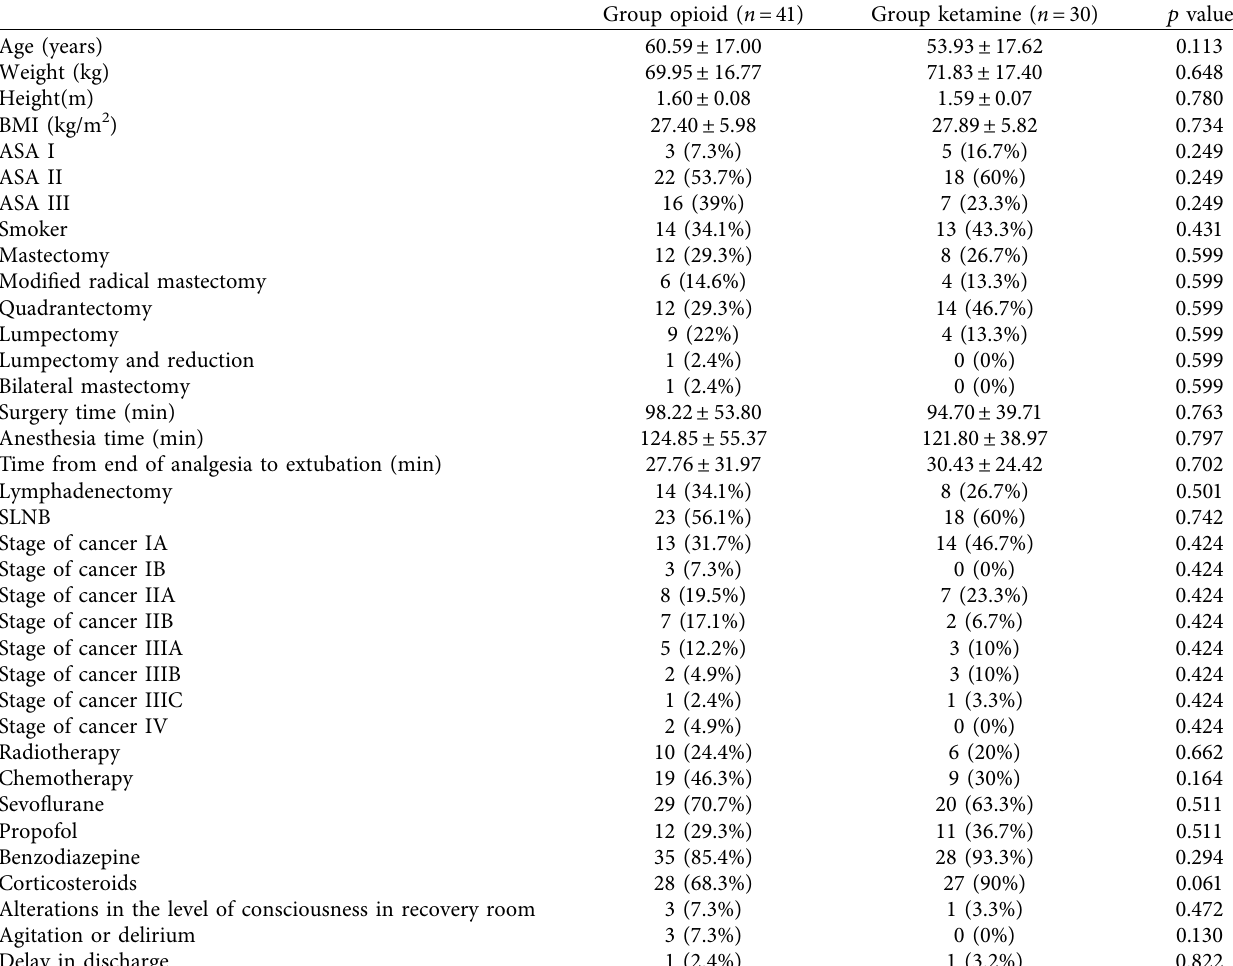
Table 1: Results of variables analysed in the study, differentiated by